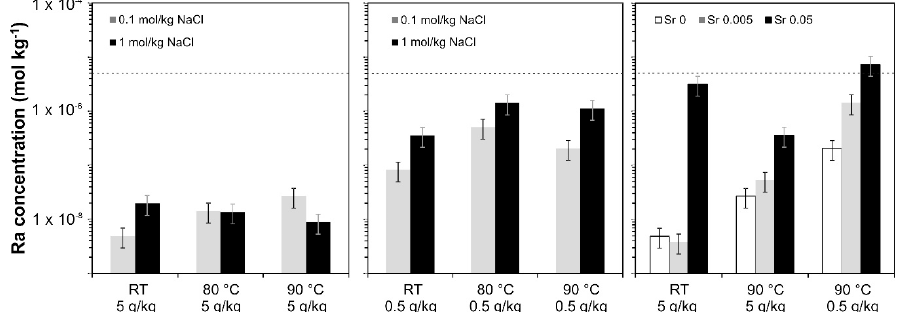
Figure 8. Ra aq concentrations at the end of experiments. The dashed lines indicate the starting concentrations of Ra aq .